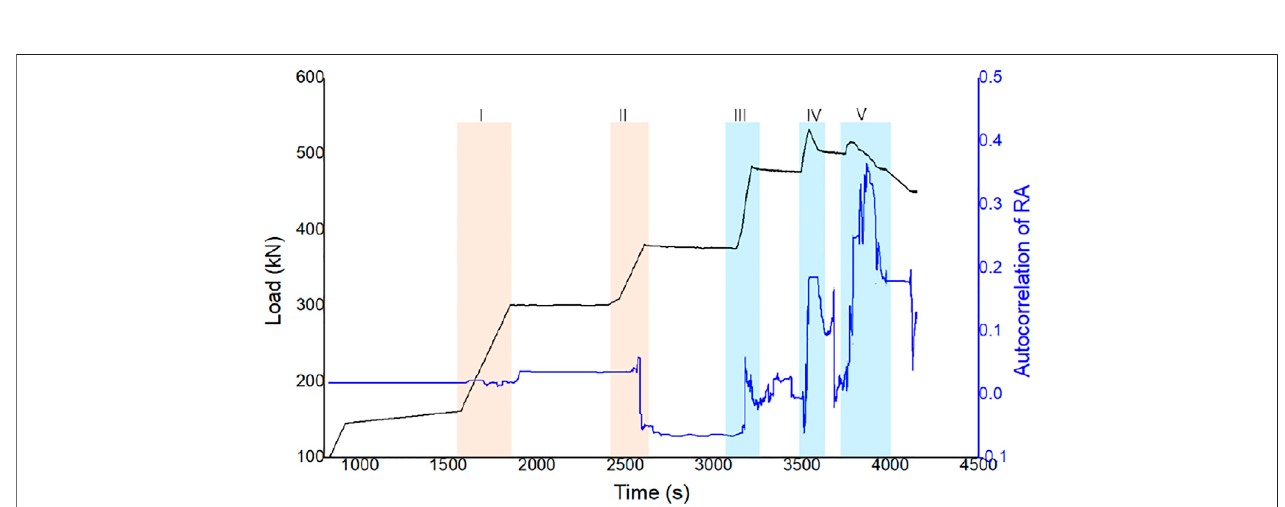
FIGURE 10 | Stage changes of autocorrelation coef fi cient of AE characteristics of rock under multi-phase uniaxial compression.